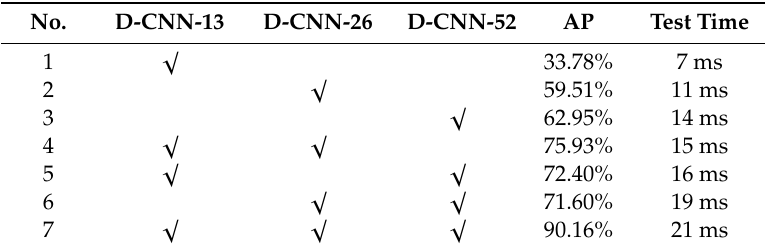
Table 4. The AP and detection time of different scales.